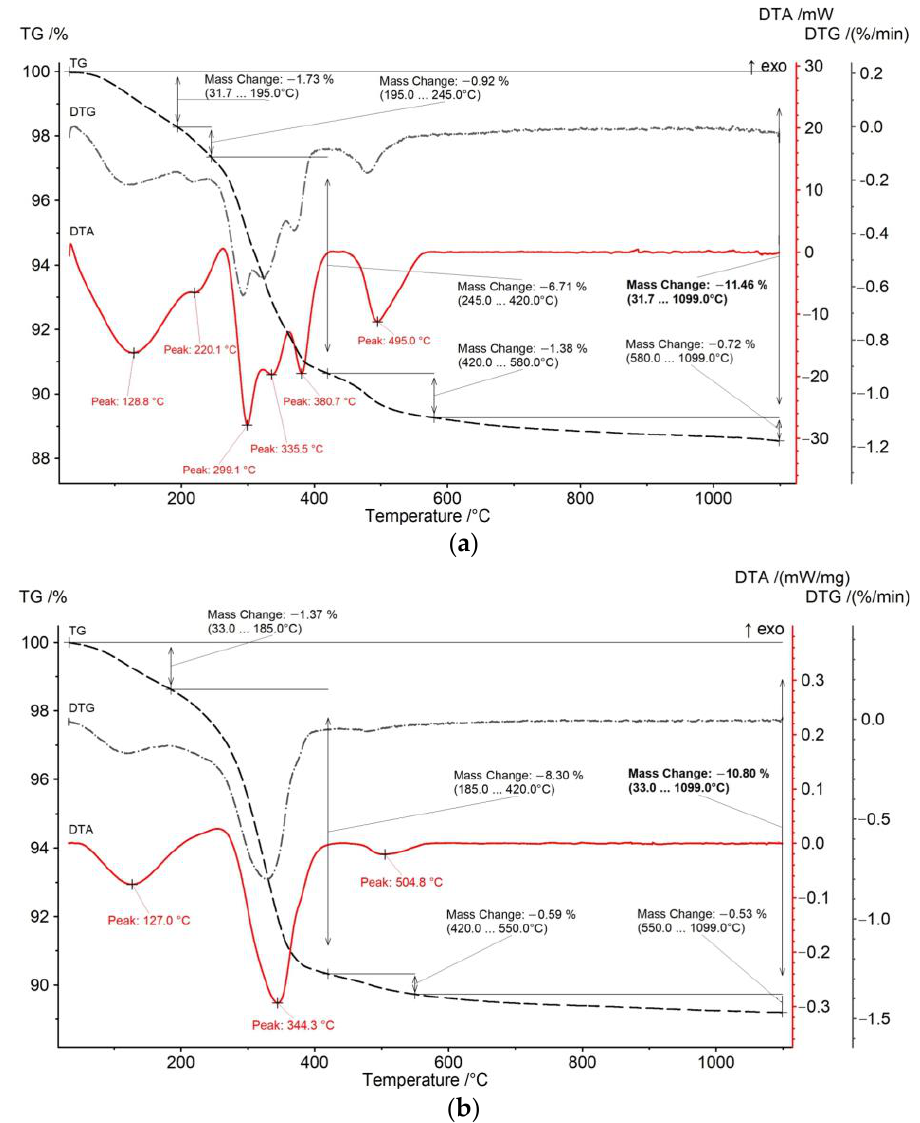
Figure 4. TG-DTA curves of the BR ( a ) and sands ( b ) at varying temperatures.